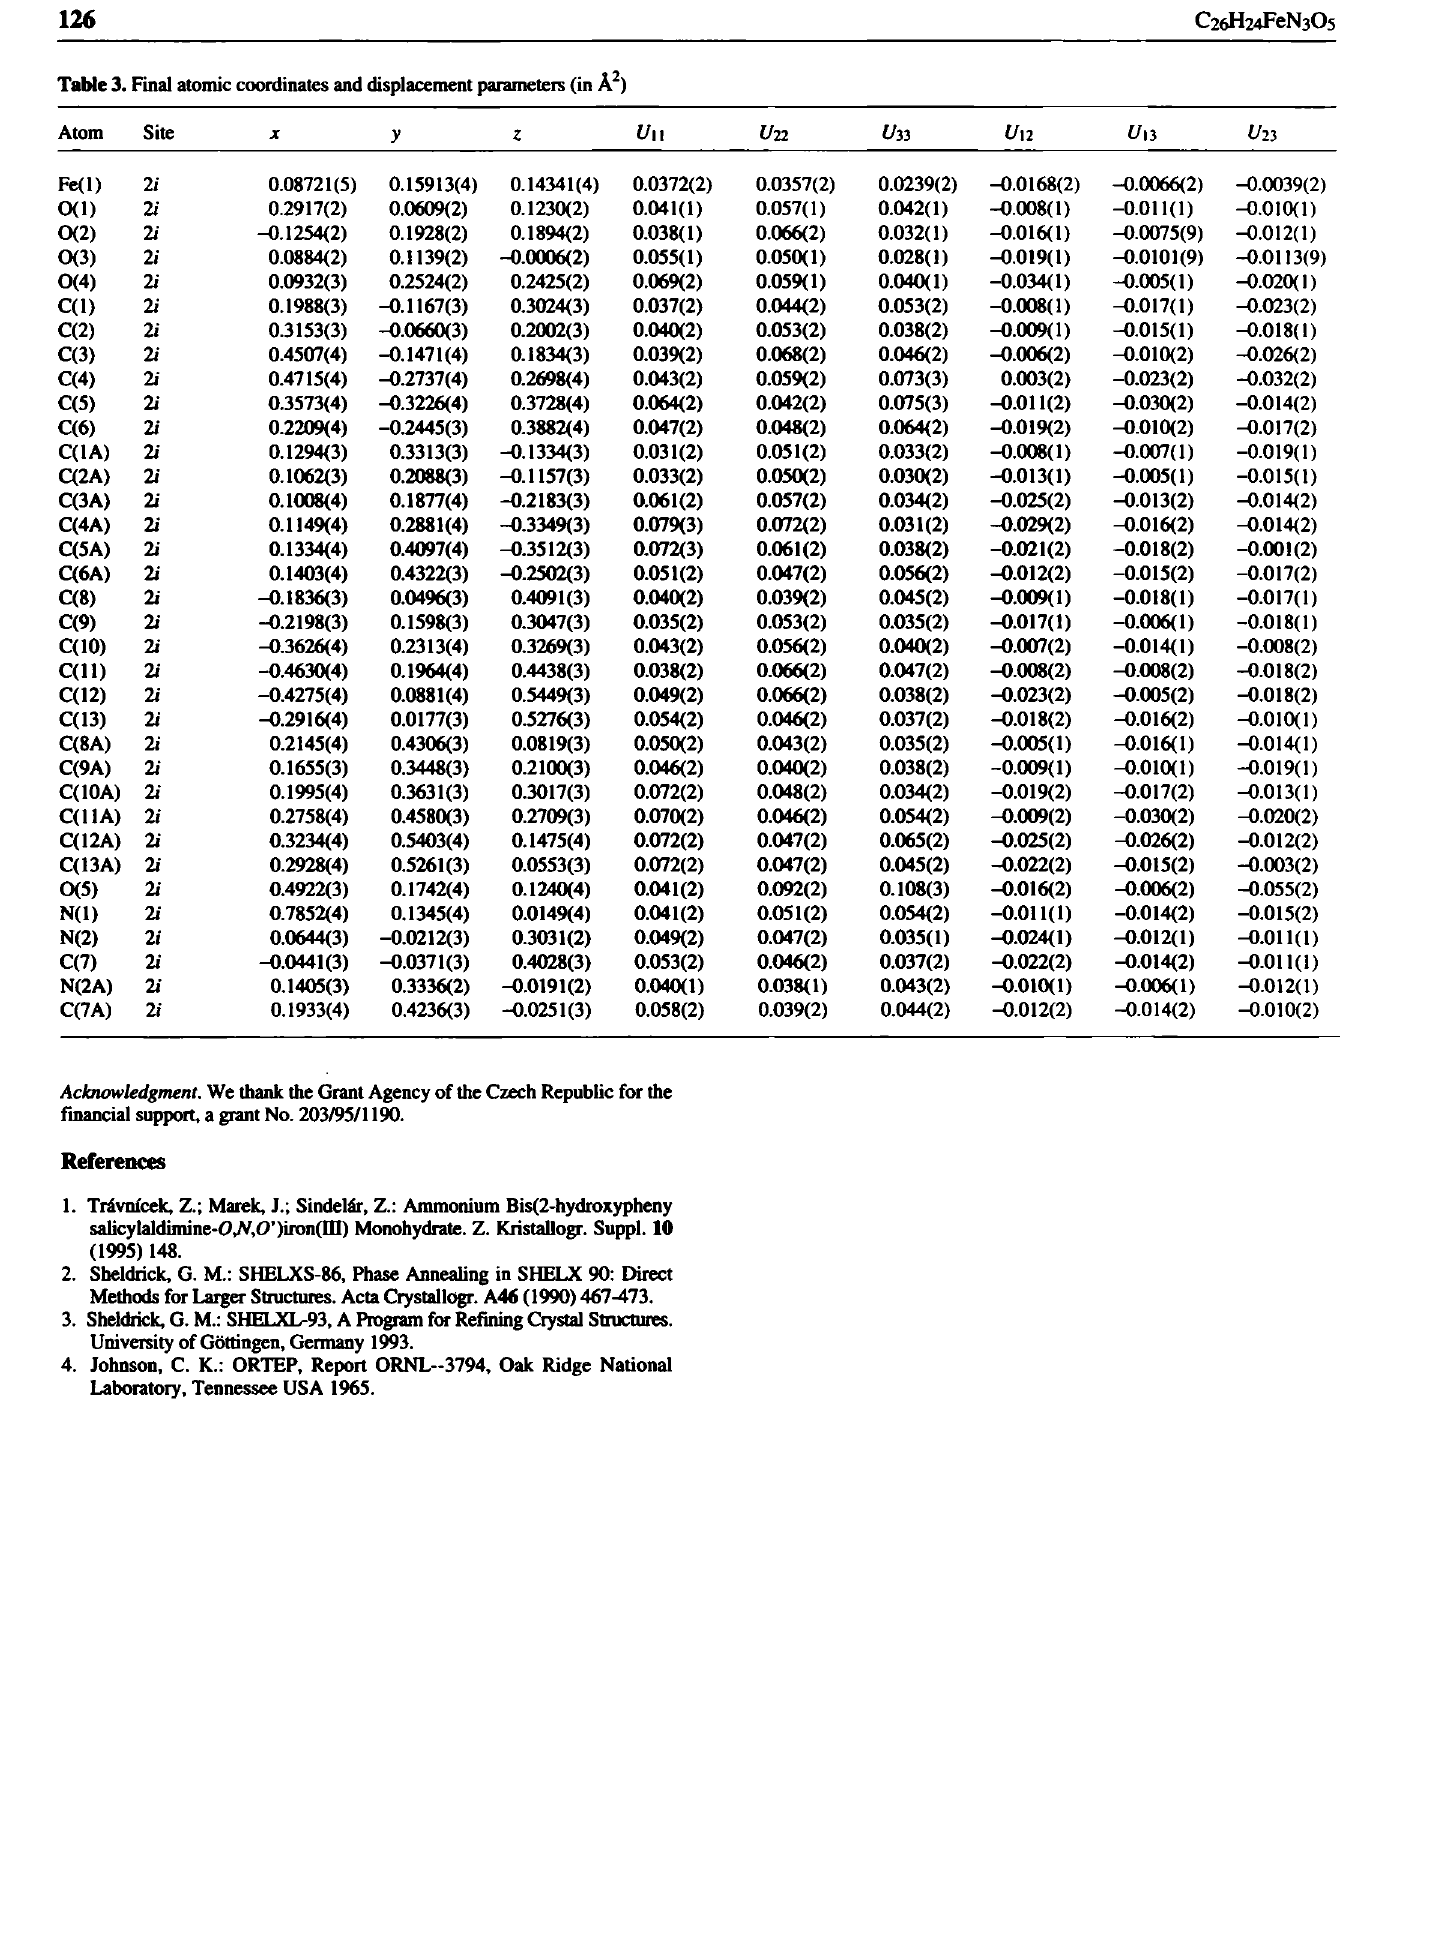
Table 3. Final atomic coordinates and displacement parameters (in A 2